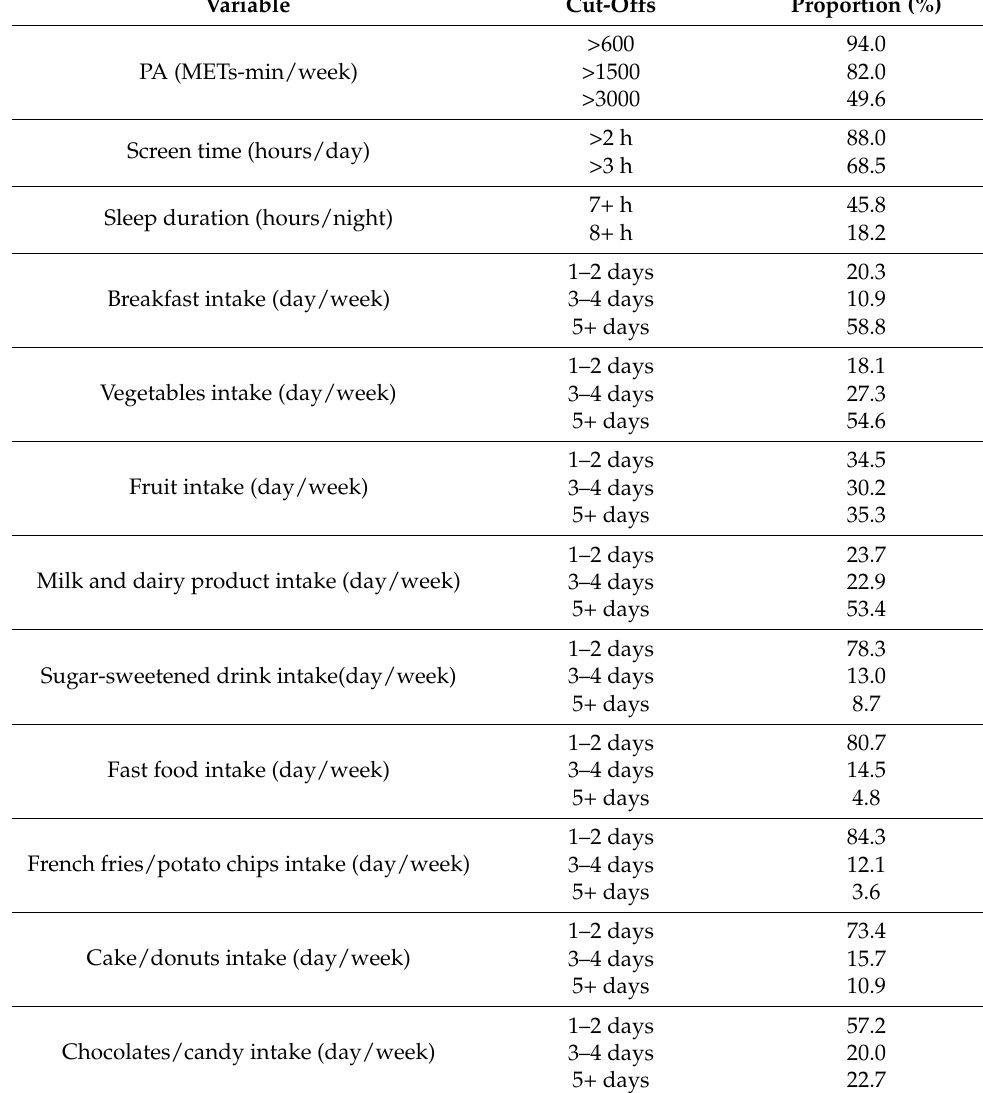
Table 2. Proportion (%) of selected lifestyle variables at or above certain cut-off scores in female participants.